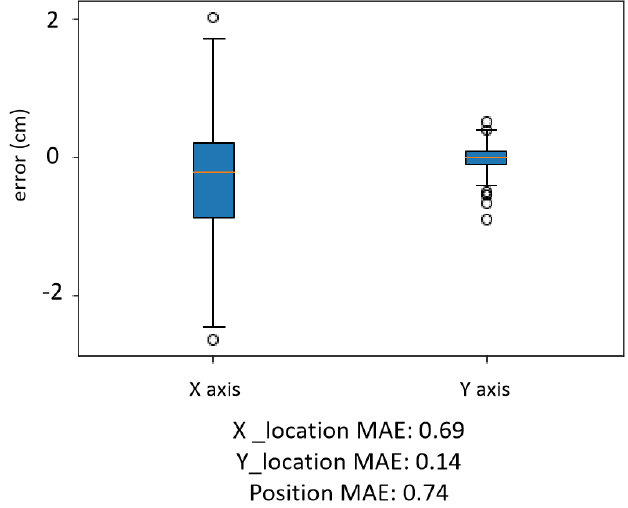
Figure 5. Localization errors of test set predicted by RRMS